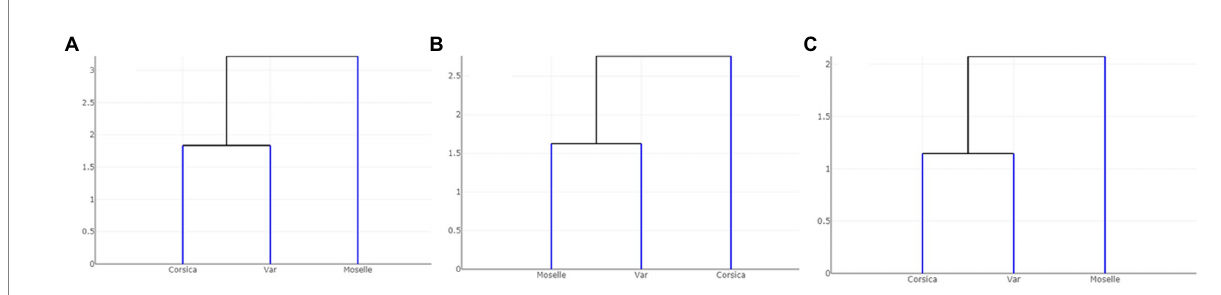
FIGURE 8 Dendogram trees based on Mahalanobis distances between populations of Culicoides circumscriptus computed from shape variables: (A) landmarks; (B) outlines-1 located at the apex of the wing; (C) outlines-2 located in cell m4 of the wing.